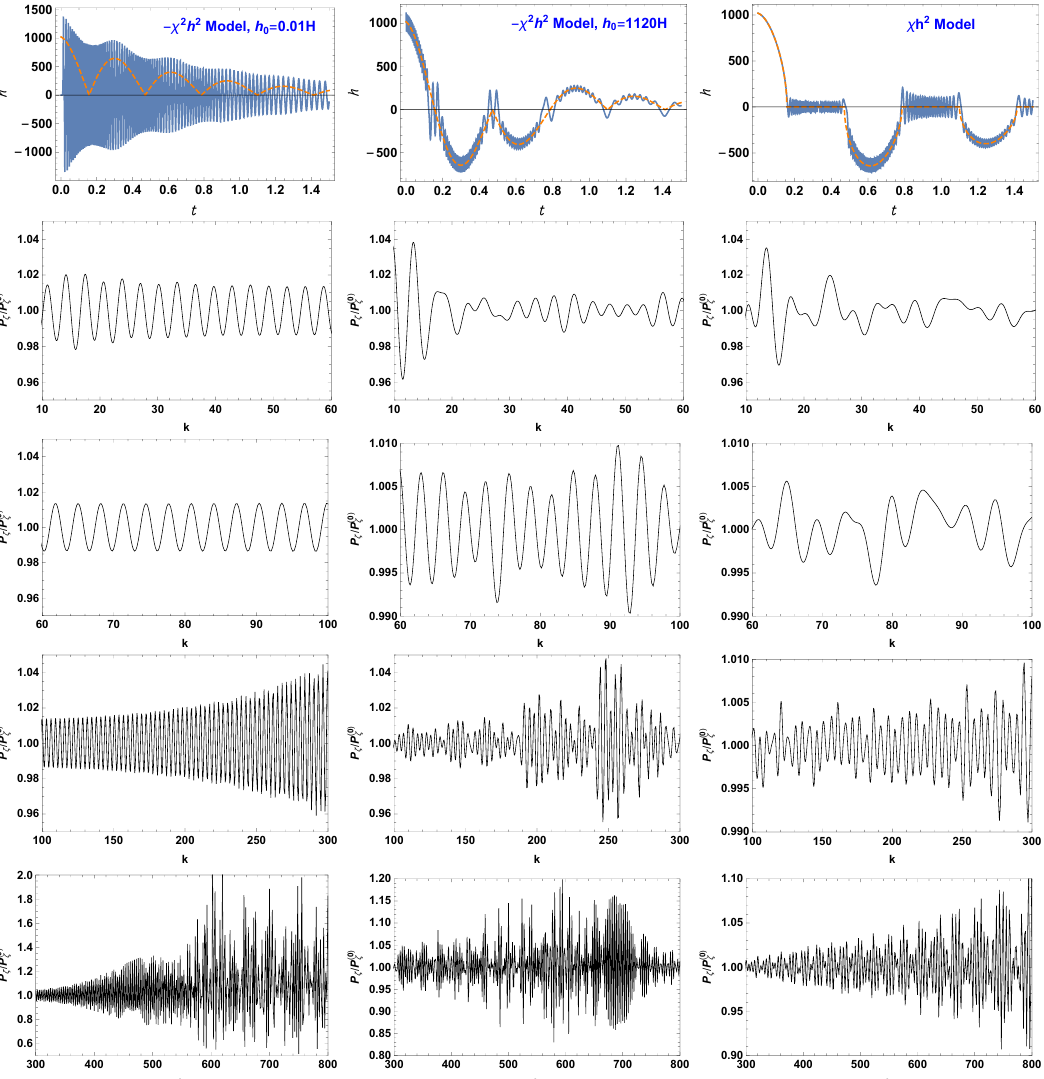
Figure 7 . The (cid:12)rst column correspond to (cid:0) M 2